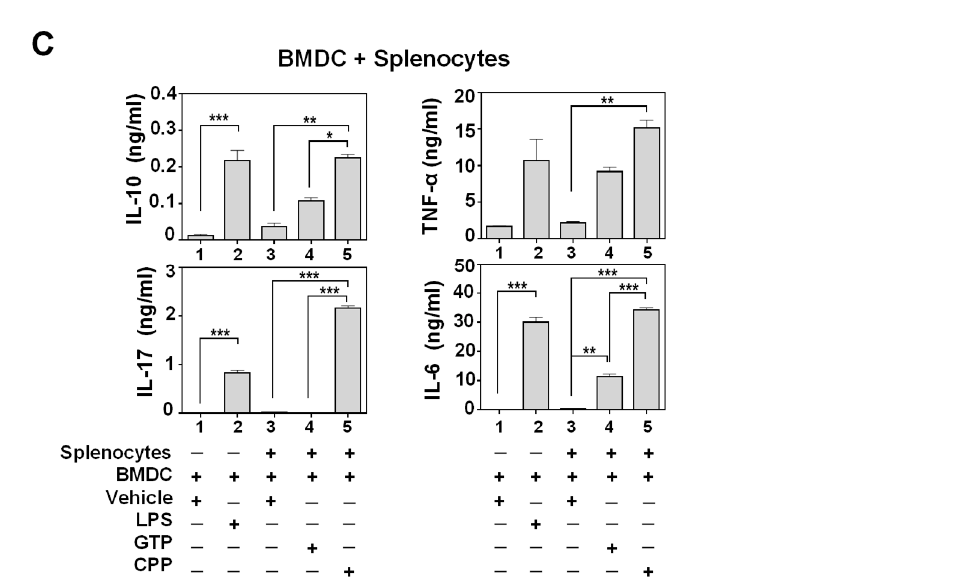
Figure 1. Food-derived polysaccharides carrot pomace polysaccharide (CPP) and green tangerine polysaccharide (GTP) promoted the maturation and activation of bone marrow-derived dendritic cells (BMDCs). ( A , B ) GM-CSF-derived BMDC cells were treated with carrot pomace polysaccharides (CPP) or green tangerine polysaccharides (GTP), lipopolysaccharide (LPS), or vehicle at the following concentrations for 24 h and analyzed by flow cytometry ( n = 3–5); LPS: 0.1, 1, 10, 100 ng / mL; CPP: 100, 200, 400, 600, 800, 1000 µ g / mL; GTP: 50, 100, 200 µ g / mL. Relative mean fluorescence intensity (MFI) (%) = (polysaccharides-treated sample MFI–vehicle MFI) / vehicle MFI * 100. ( c ) BMDCs from C57BL / 6 mice were treated with vehicle, CPP (1000 µ g / mL), or GTP (100 µ g / mL) for 24 h, and co-cultured with BALB / c splenocytes for 3 days. lane1: BMDC + vehicle, lane2: BMDC + LPS, lane3: BMDC + splenocytes + vehicle, lane 4: BMDC + splenocytes + GTP, lane 5: BMDC + splenocytes + CPP. Cytokine levels in mixed lymphocytes’ culture supernatants were quantified with the BD CBA mouse cytokine kit ( n = 2). Statistical di ff erence by unpaired t-test relative to vehicle ( A , B ) or one-way ANOVA with Tukey’s post hoc test ( C ). * p < 0.05, ** p < 0.01, *** p <